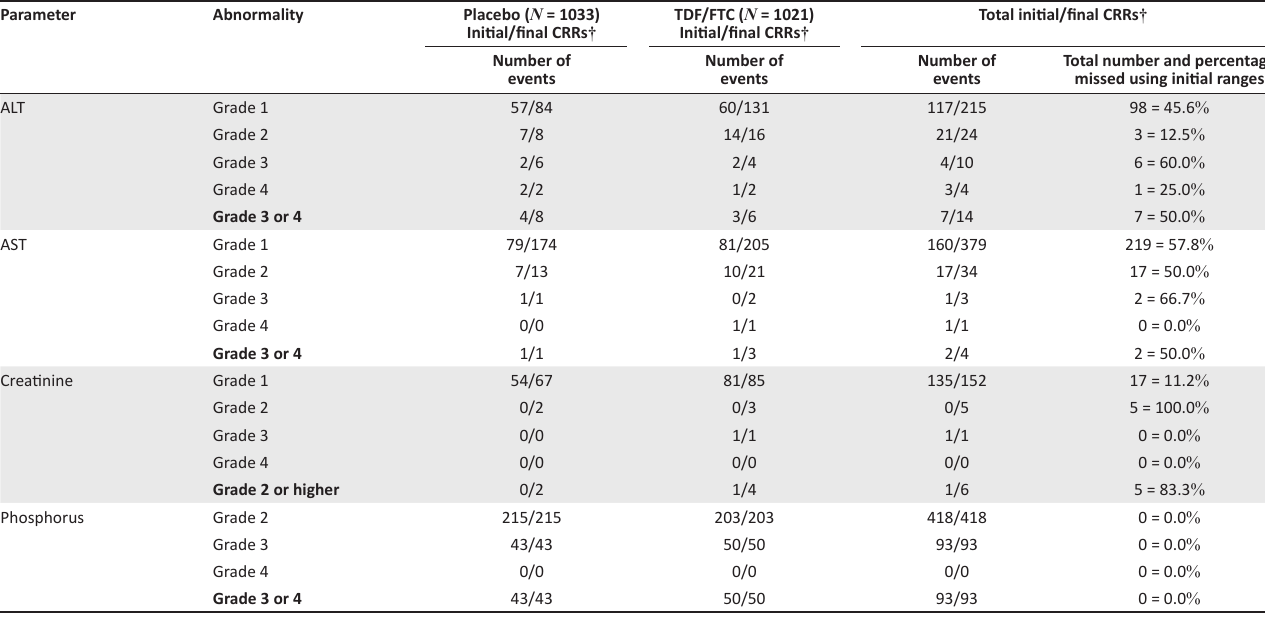
TABLE 5: Laboratory abnormality frequency tables based on the initial versus final chemistry reference ranges.